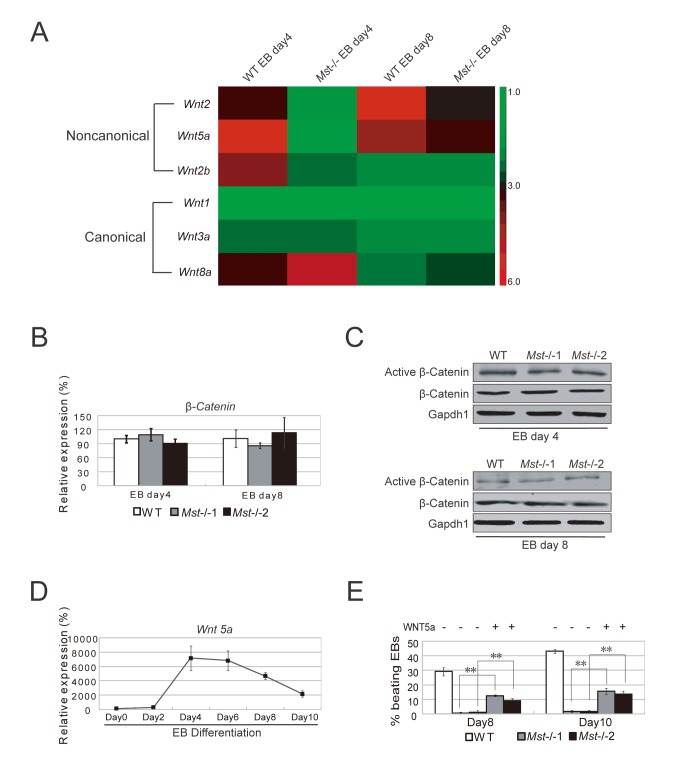
ES cell to cardiac progenitor cell differentiation is disturbed by Mst1/Mst2 depletion.(A) Heatmap of the expression of non-canonical Wnt signaling ligands (Wnt2, Wnt2b and Wnt5a) and canonical Wnt ligands (Wnt1, Wnt3a, Wnt8a and Wnt11) in day 4 and day 8 wild type EBs and Mst-/- EBs. (B) Relative mRNA levels of β-catenin in wild type and Mst-/- EBs at day 4 and day 8 during EB formation. Actin was used as an internal control. The data are shown as the mean ± S.D (n=3). Statistically significant differences are indicated (*, P<0.05; **, P<0.01; ***, P<0.001). (C) Immunoblotting analysis with antibodies against Active β-catenin and total β-catenin to check its expression in day 4 and day 8 wild type EBs and Mst-/- EBs. Gapdh1 was analyzed as an internal control. (D) Relative mRNA levels of Wnt5a during EB formation from day0 to day10. Actin was used as an internal control. The data are shown as the mean ± S.D (n=3). Statistically significant differences are indicated (*, P<0.05; **, P<0.01; ***, P<0.001). (E) Recombinant Wnt5 were supplemented to the Mst-/-EB culture from day 2 and day 10. Wild type EBs and Mst-/- EBs were grown in non-Wnt5a supplemented medium as controls. The percentage of beating EBs was profiled on day 8 and day 10 after initiating EBs culture. The data are shown as the mean ± S.D (n=3). Statistically significant differences are indicated (*, P<0.05; **, P<0.01; ***, P<0.001).